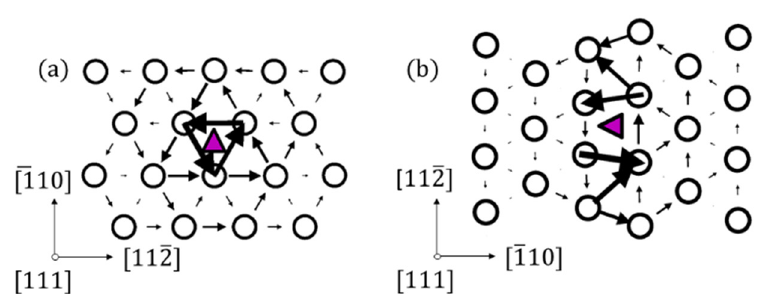
Figure 4. ( a ) ½<111> screw and ( b ) M111 mixed dislocations. The location of the dislocation core is marked as a purple triangle. The [111] (screw) component of the relative displacement of the neighboring atoms produced by the dislocation is depicted as an arrow between them.